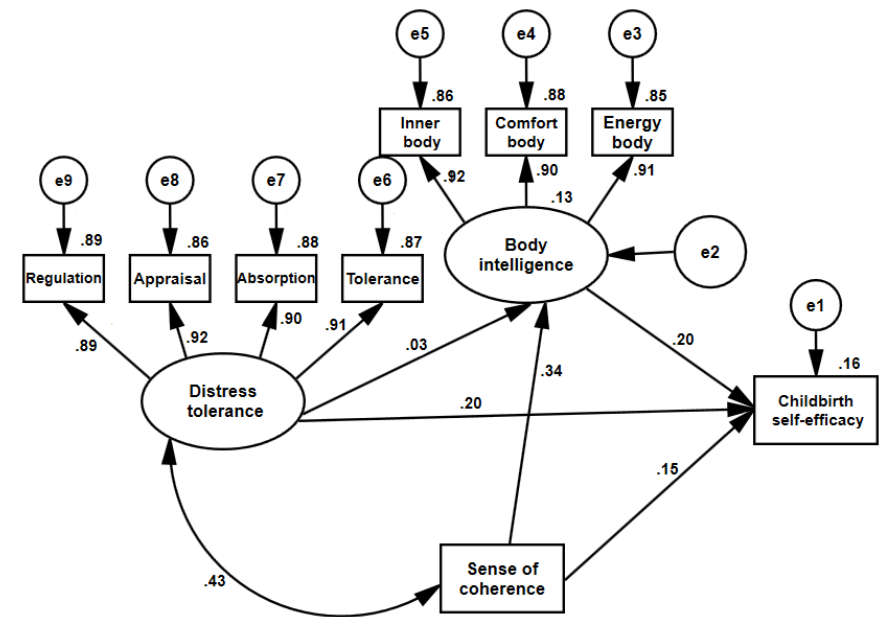
Figure 1 . The model for predicting childbirth self-efficacy based on the sense of coherence and distress tolerance with the mediating role of body